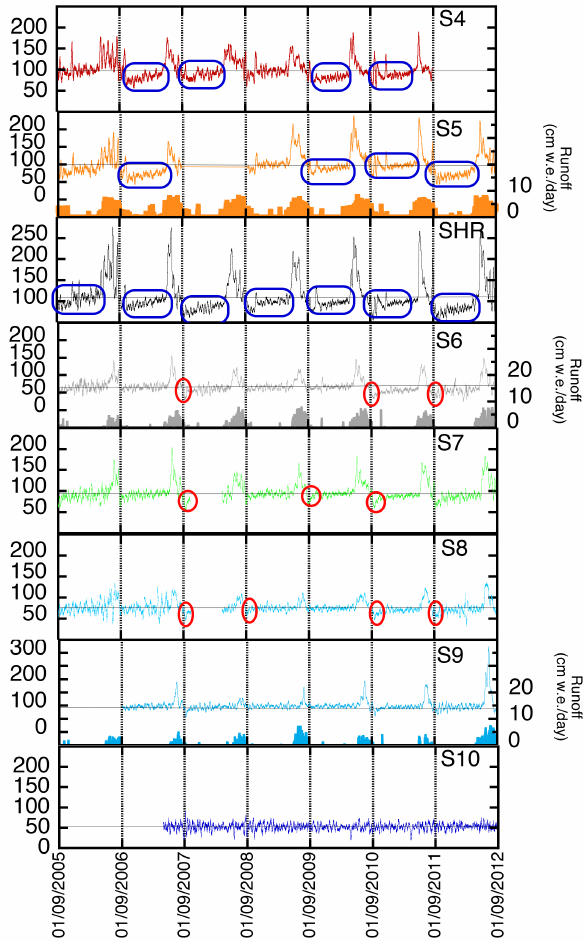
Figure 2. Velocity records from the eight sites on the K-transect with 7 years of data. Data are plotted with respect to their mean val- ues (grey line) and sorted from the ice margin (top) to the accumu- lation area (bottom), 150km from the margin. Note some similar patterns: increase in winter velocity encircled blue and dip in au- tumn velocity encircled red. For S5, S6 and S9, melt based on AWS data is shown for reference on the right axis. Data in this figure are available in the